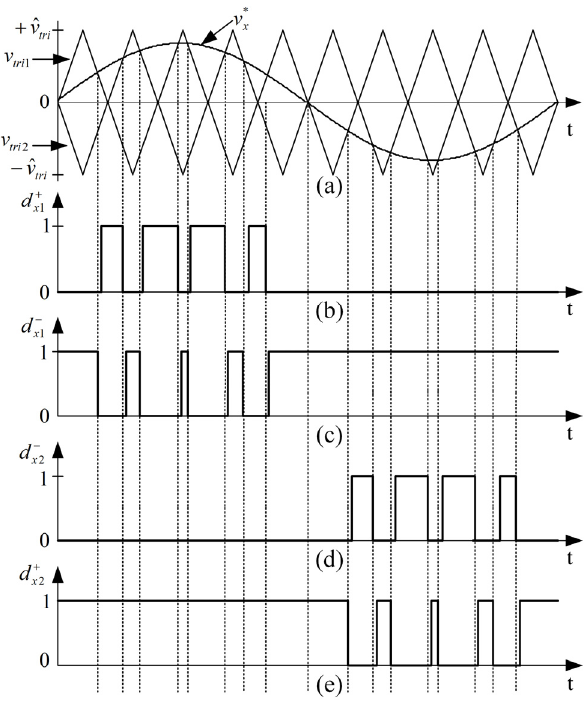
Figure 6. Switching pattern of the three-phase, three-level